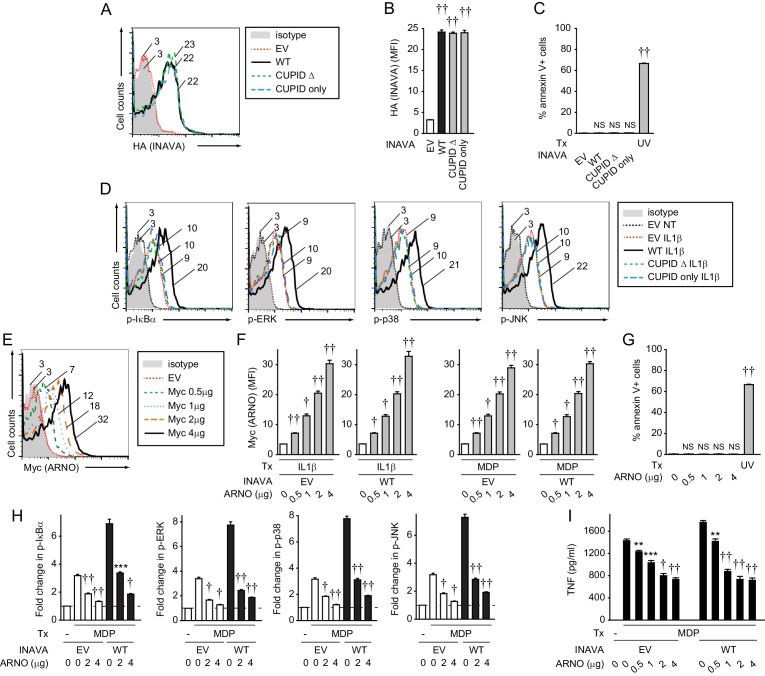
ARNO inhibits INAVA-dependent NOD2-induced signaling and cytokine secretion.(A–D) MDMs from rs7554511 CC homozygote (low-expressing) INAVA carriers were transfected with empty vector (EV) or the indicated HA-INAVA constructs. (A) Representative flow cytometry of INAVA constructs with mean fluorescent intensity (MFI) values as indicated. (B) Summary graph of INAVA expression (as detected by HA antibody) with MFI +SEM (n = 6, similar results seen in an additional n = 10). (C) Cells were stained with annexin V (BD Biosciences). Percent dead cells + SEM. UV stimulation at 50–100 J/m2 served as a positive control. (D) Representative flow cytometry for Figure 4D with MFI values as indicated. (E–I) MDMs (n = 6) from rs7554511 CC homozygote (low-expressing) INAVA carriers were transfected with empty vector (EV) or HA-INAVA, and Myc-ARNO vector at the indicated concentrations. (E and F) Cells were left untreated or treated with 10 ng/ml IL-1β or 100 μg/ml MDP for 24 hr. (E) Representative flow cytometry with MFI values as indicated, and (F) summary graphs with MFI values of ARNO expression (as detected by Myc antibody)+SEM (similar results seen in an additional n = 6 for MDP-treated conditions). (G) Cells were stained with annexin V. Percent dead cells + SEM. UV stimulation at 50–100 J/m2 served as a positive control. (H–I) Cells were treated with 100 μg/ml MDP. (H) Summary graphs with fold MFI of indicated phospho-kinases at 15 min +SEM. (I) Mean TNF secretion at 24 hr + SEM. Significance is compared to treated cells without ARNO transfection (EV) for each respective condition for (H and I). Tx, treatment; EV, empty vector; NS, not significant; **, p<0.01; ***, p<0.001; †, p<1×10−4; ††, p<1×10−5.